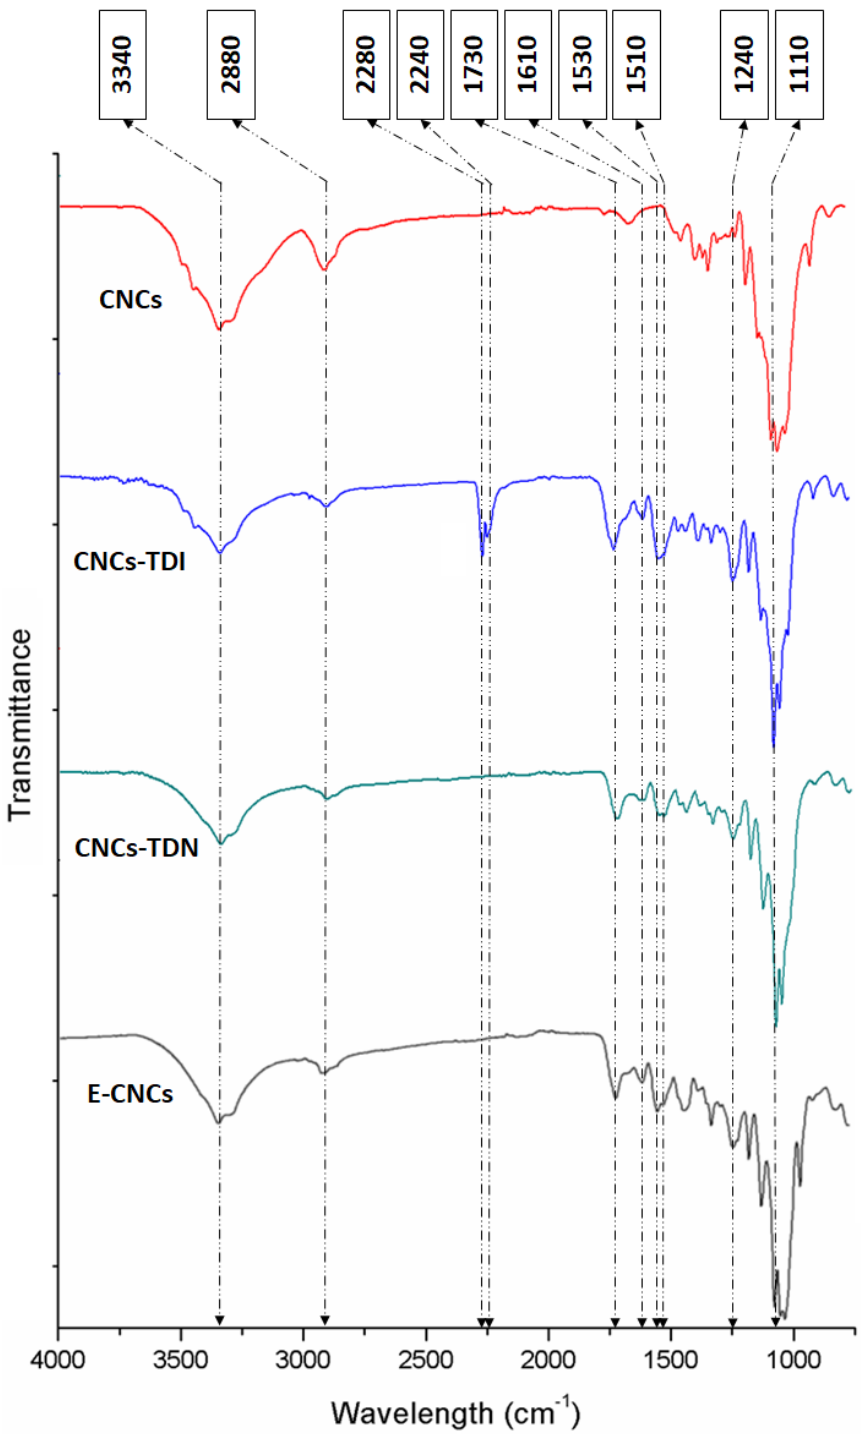
Figure 5. FT-IR spectra of the original CNCs, after carbamation using 2,4-TDI (CNCs-TDI), hydrolysis using HCl-acidified DMSO (CNCs-TDN), and after polymerization using APS (E-CNCs).